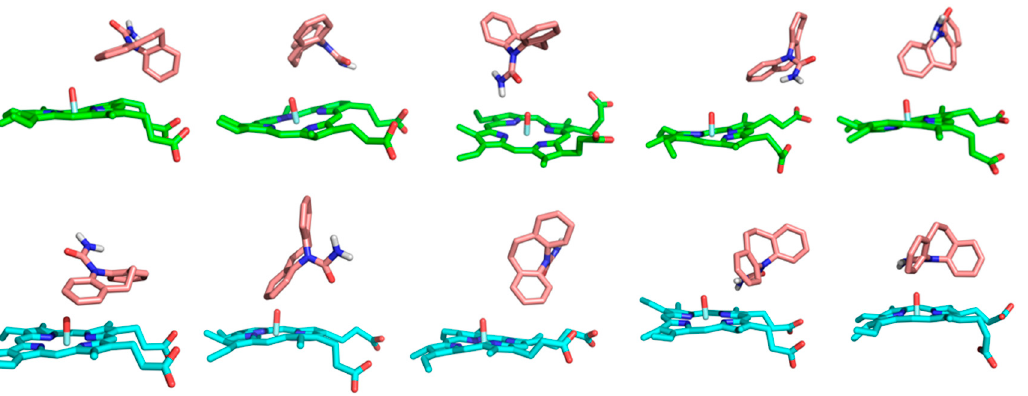
Figure 4. Representative conformations of the substrate CBZ in the active site of CYP3A4 ( upper ) and CYP3A5 ( lower ) during the MD simulation.